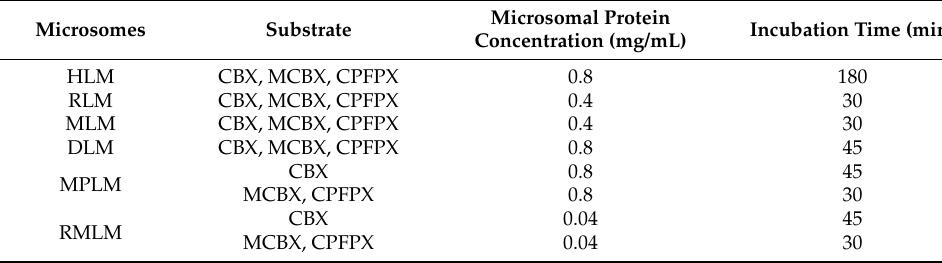
Table 6. Incubation conditions for generation of in vitro metabolite